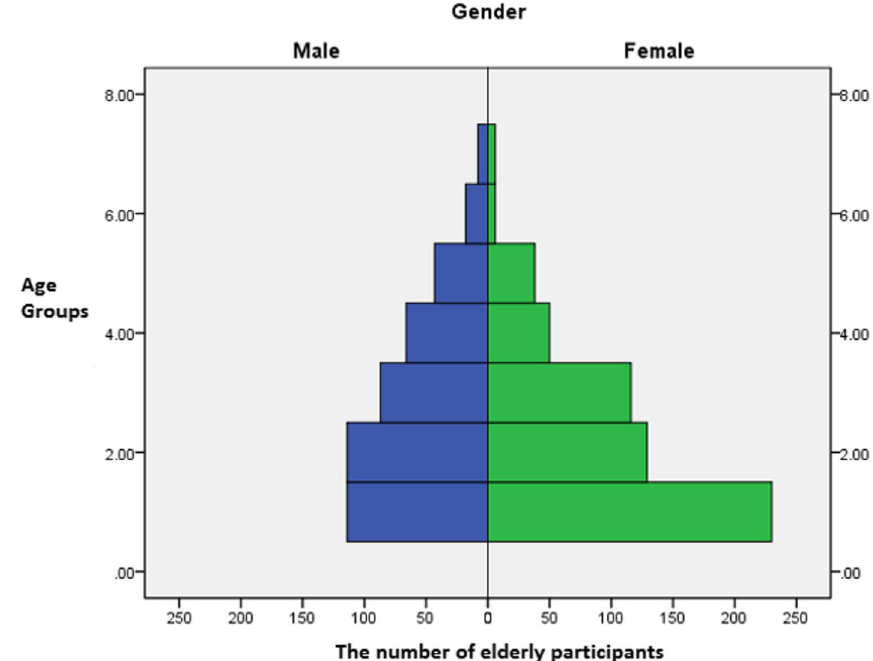
Fig. 1 The age pyramid of the elderly participants. Age groups: 0–2 : 60–70 years; 2–4 : 71–80 years; 4–6 : over 80